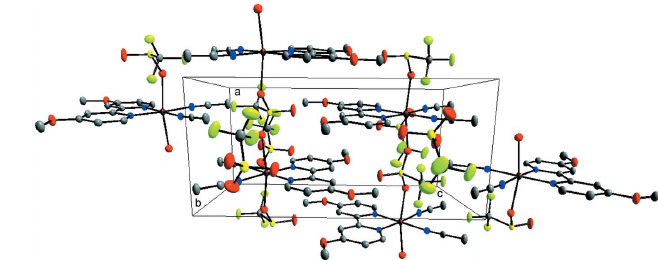
Figure 1 Asymmetric unit of the title compound with displacement ellipsoids drawn at the 50% probability level; H atoms are omitted for